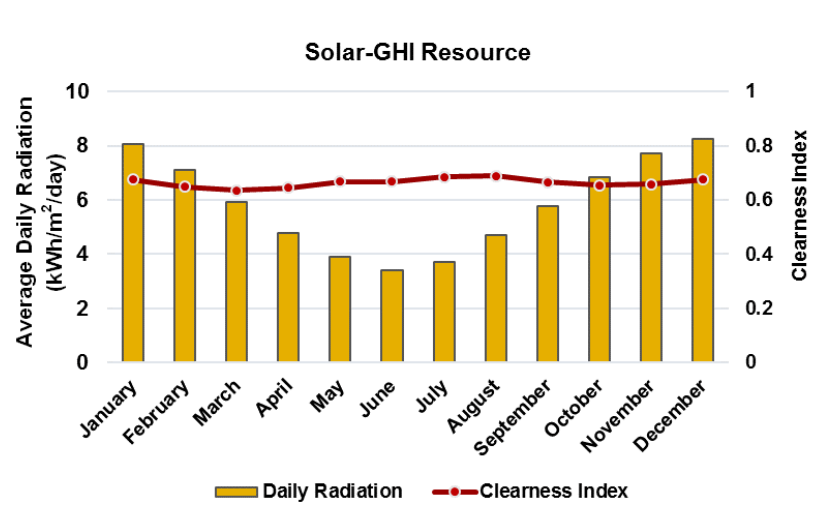
Figure 4. Monthly average solar GHI in South Africa.